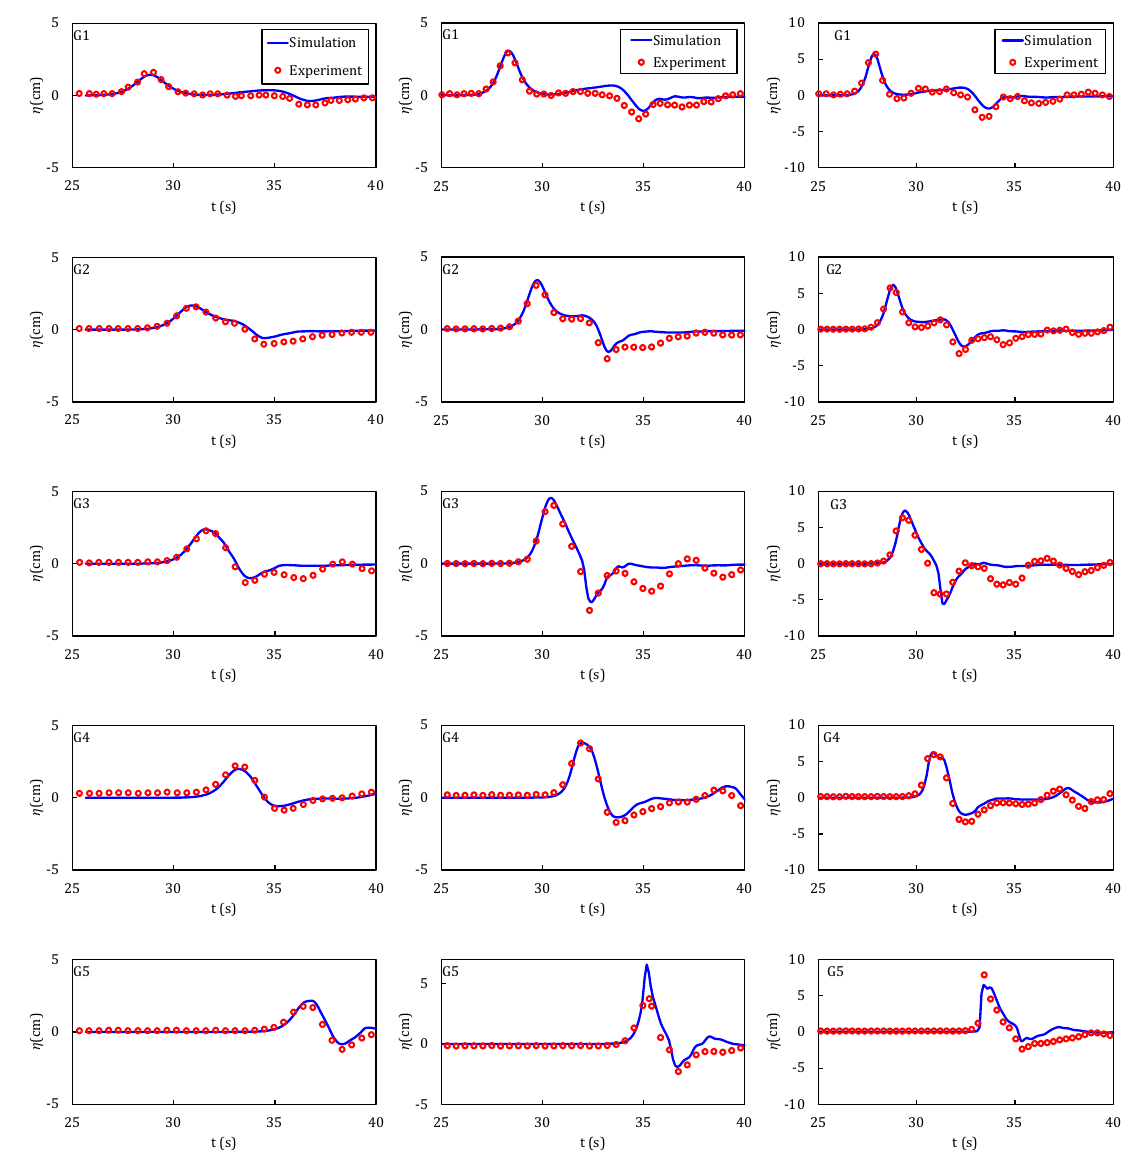
Figure 11. Comparisons of numerical simulation and experiments for runup of a solitary wave on a circular island. The first column is the relative wave height at condition H / d = 0.45; the second column is the relative wave height at condition H / d = 0.096; the third column is the relative wave height at condition H / d = 1.81.